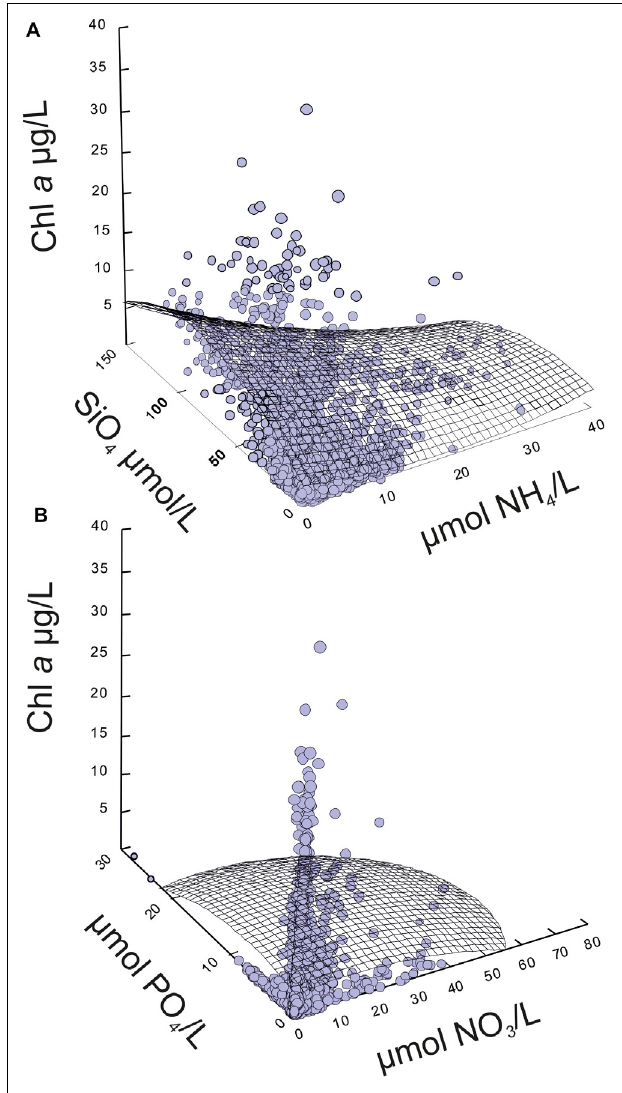
FIGURE 8 | Relationship between chlorophyll a concentration and nutrients in the water column in the Mar Menor lagoon during the eutrophication process from 1997 to 2018. (A) Regression model using silicate and ammonium as independent variables. (B) Regression model using phosphate and nitrate as independent